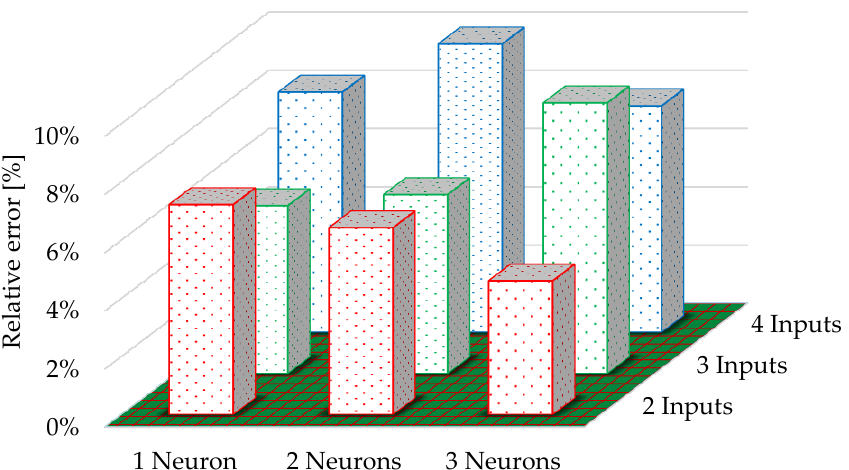
Figure 3. Summary of learning results for the best-adjusted neural networks for the characteristic of specific fuel consumption. The calculated relative error between the model and actual data: 2 inputs: engine rotational speed, engine torque; 3rd input: vehicle gear number; 4th input: vehicle speed.